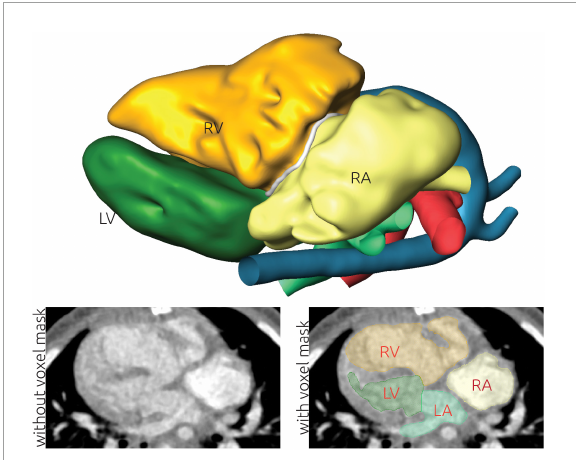
FIGURE1 Illustration of the image-based reconstruction of a patient-specific anatomy using computed tomography (CT) data. The top panel shows the resulting 3D surface geometry of the patient. The lower left panel shows a CT image slice without labels. The grayscale window is set to a range from -500 to +500 Hounsfield units. This image is superimposed using the labels generated during image reconstruction in the lower right panel. Here, the left (LA) and right atrium (RA), as well as the left (LV) and right ventricle (RV) are